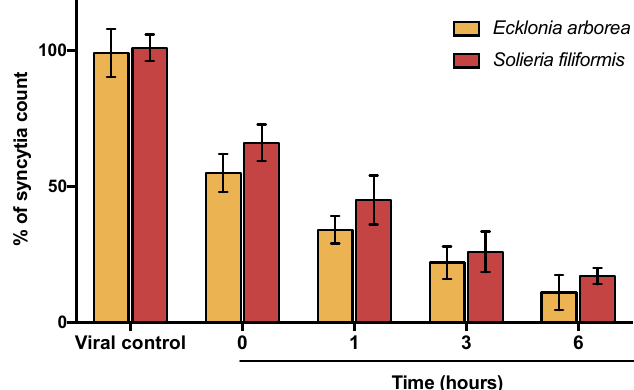
Figure 3. Virucidal effect of PPs . Vero cells were infected with MeV previously exposed to PPs at different times (0, 1, 3 and 6 h). Syncytia count is given in % of the untreated control values. Each bar represents the average of three replicates.